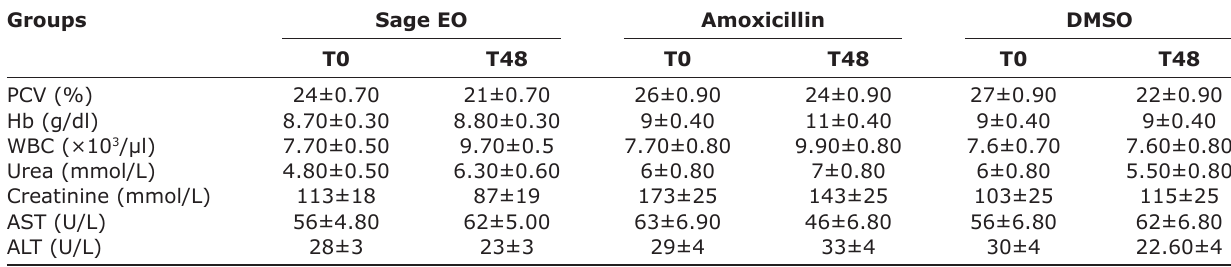
Table-3: Effects of intramammary infusion of sage EO on selected blood hematology and serum biochemical parameters in Awassi sheep affected with subclinical mastitis (mean±SD). Groups Sage